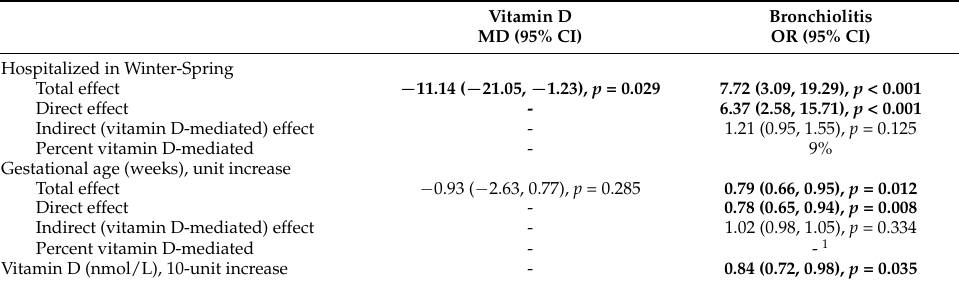
Table 2. Characteristics of the study sample by group.